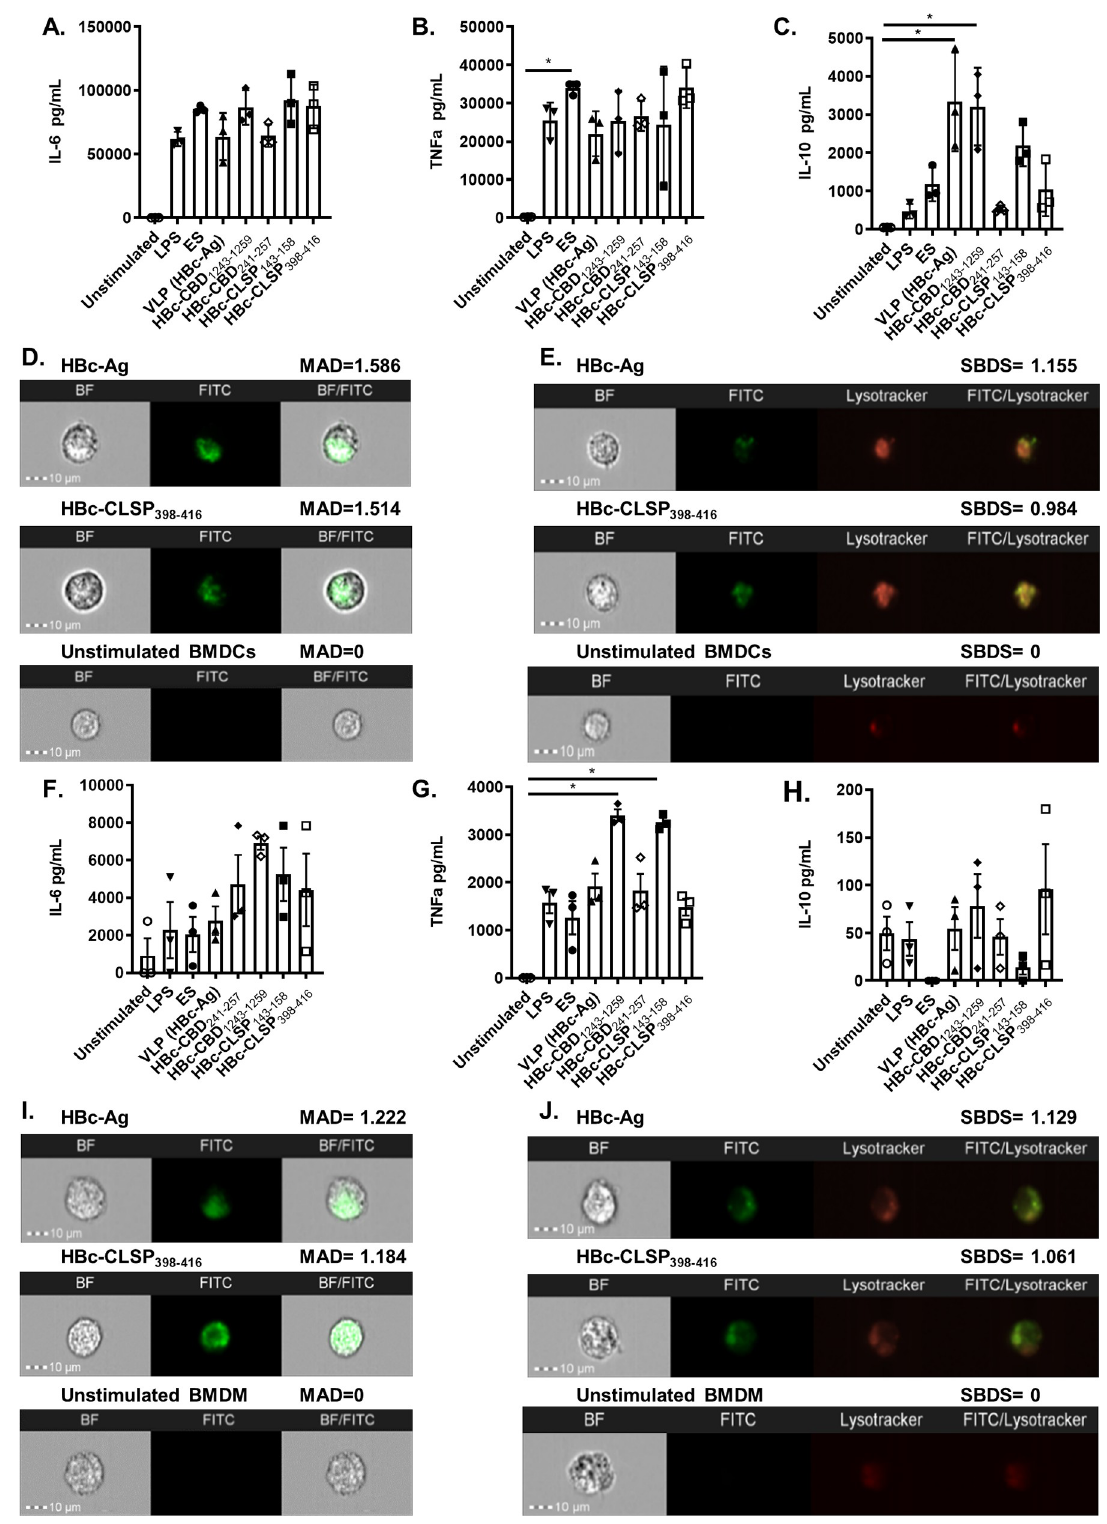
Fig 2. Inflammatory cytokine production by mouse bone marrow-derived DCs (BMDCs) and mouse bone marrow-derived macrophages (BMDMs) in response to VLPs. (A-C) BMDCs and BMDMs (F-H) at 1X10 6 /ml were stimulated in vitro with 10 μ